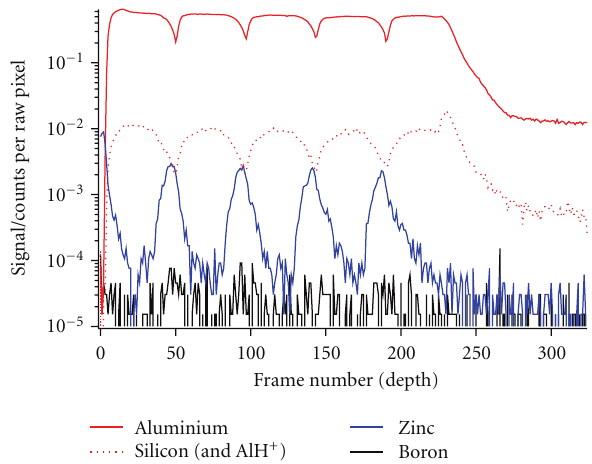
Figure 15: FIB-SIMS depth profile of ALD multilayer (five repeats of nominally 20nm zinc oxide/20 nm aluminium oxide on a silicon substrate). 240pA, 5 keV normally incident Ga+ bombardment. For clarity, each trace is on a di ff erently scaled linear vertical axis. The surface of the sample is to the left of the figure, the substrate to the